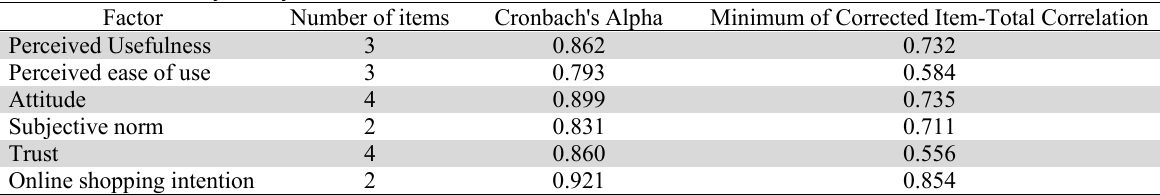
Results of reliability